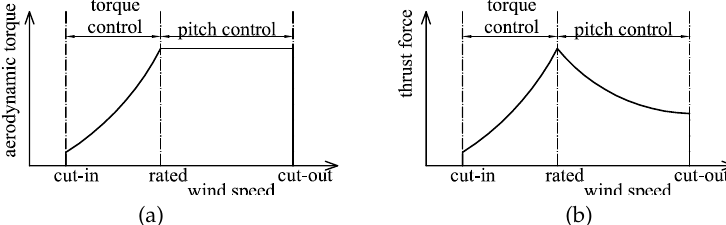
Figure 6. Schematic representation of ( a ) the aerodynamic torque, and ( b ) the thrust force on a turbine rotor as a function of the upstream wind speed.